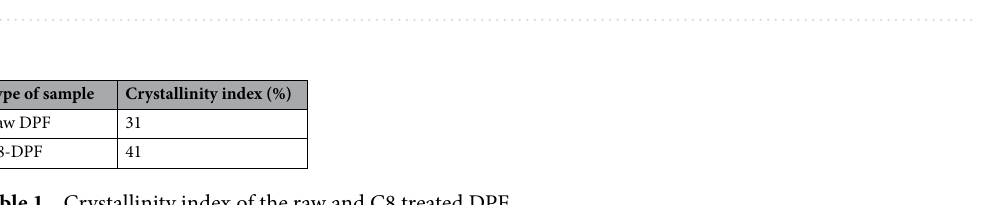
Figure 7. XRD patterns for raw and C8 treated DPF.